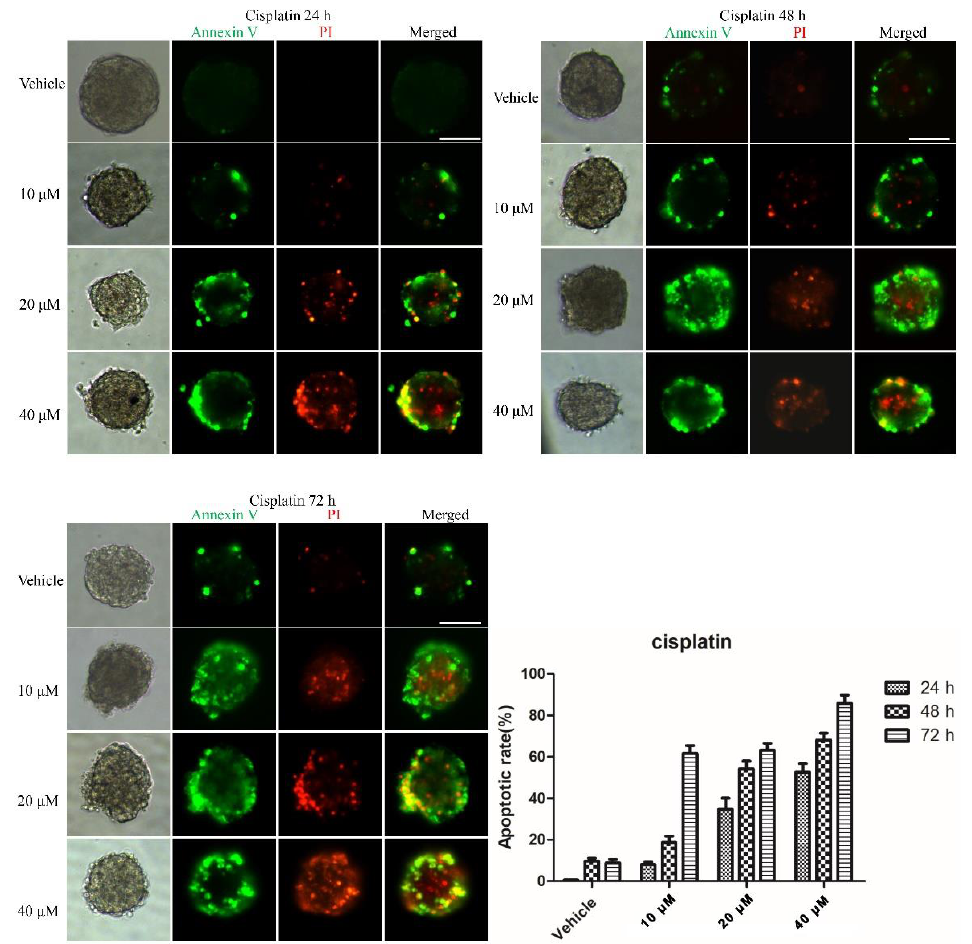
Figure 6. Immunofluorescence analysis of apoptotic marker (Annexin V, green) and necrotic marker (PI, red) after drug (cisplatin) treatment in the 3D spheroid models. The fraction of the apoptotic and necrotic cells appeared to be correlated with the concentration and time. The histogram shows the apoptosis rate at the indicated concentrations after 24 h, 48 h and 72 h of the cisplatin administration (the data are presented as mean ± SD). Magnification = 20 × , Bar = 75 µ